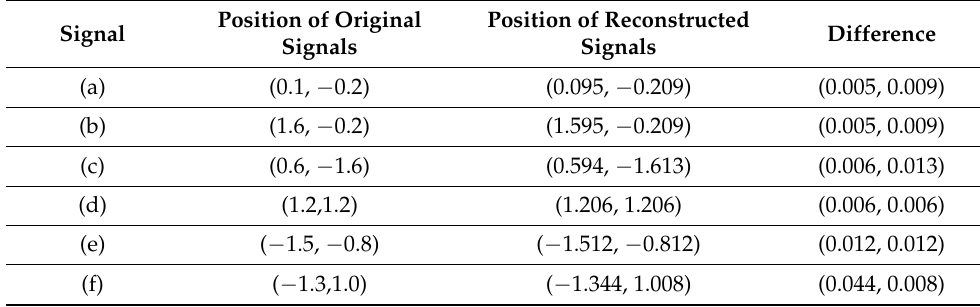
Table 2. Center positions ( x 0 , y 0 ) of the fringe patterns separated from Figure